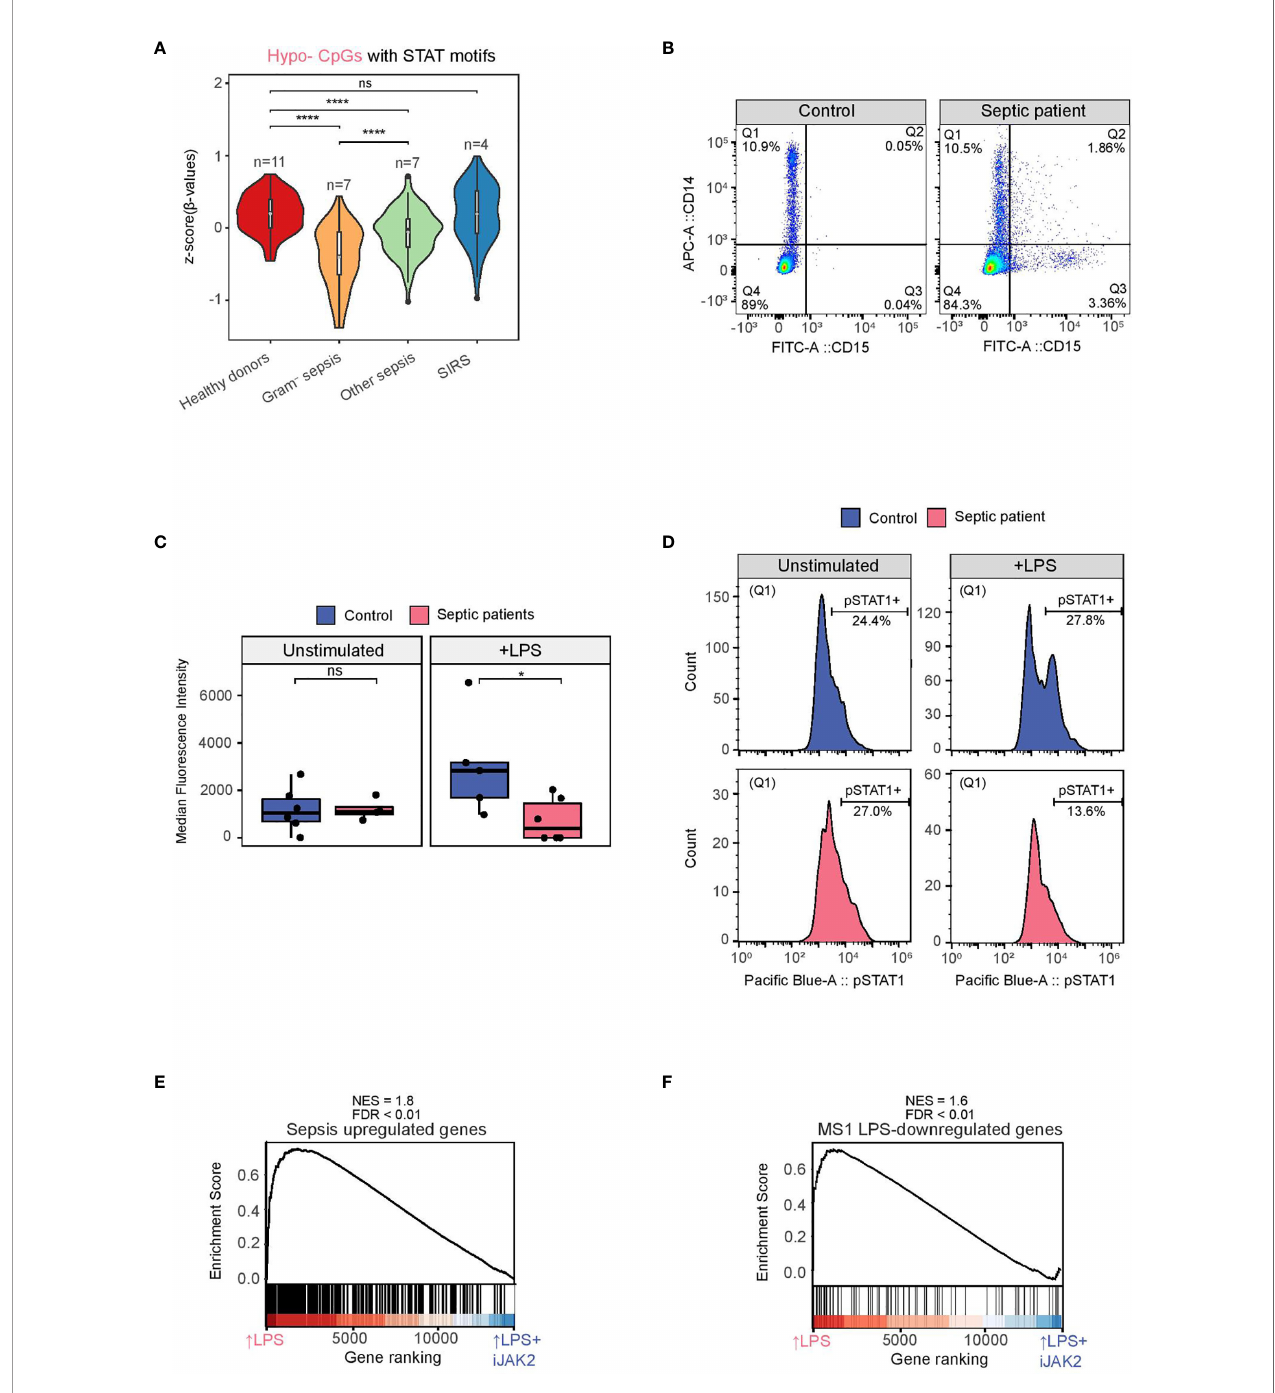
FIGURE 4 | STAT1 phosphorylation in monocytes from healthy donors and septic patients with or without an LPS stimulus. (A) Violin plot of normalized b values of the LPS Hypomethylated CpGs associated with STAT1/STAT3/STAT5 motifs in CD14+ monocytes from peripheral blood of healthy donors, gram-negative sepsis, other sepsis and SIRS patients (91 CpGs) (ns p > 0.05; **** p < 0.0001 ). (B) Example of the strategy adopted to gate only monocytes. CD14+CD15- (Q1) are mostly monocytes, whereas some CD15+ cells (neutrophils) can also express CD14 (Q2). (C) Median fl uorescence intensity (pSTAT1) of monocytes (Q1) from septic patients (pink) and healthy donors (blue), with and without an LPS stimulus. Two-tailed Wilcoxon test p values are depicted (ns p > 0.05, * p < 0.05). (D) Example of a pSTAT1 signal histogram from a healthy donor (blue) and a septic patient (pink), with and without an LPS stimulus. (E) GSEA of LPS-treated versus LPS+iJAK2- treated monocytes using Sepsis upregulated genes (logFC >1, FDR < 0.05). The running enrichment score and the normalized enrichment score (NES) are shown above the graph. (F) GSEA of LPS-treated versus LPS+iJAK2-treated monocytes using MS1 LPS-downregulated genes (40) as gene set. The running enrichment score and the normalized enrichment score (NES) are shown above the